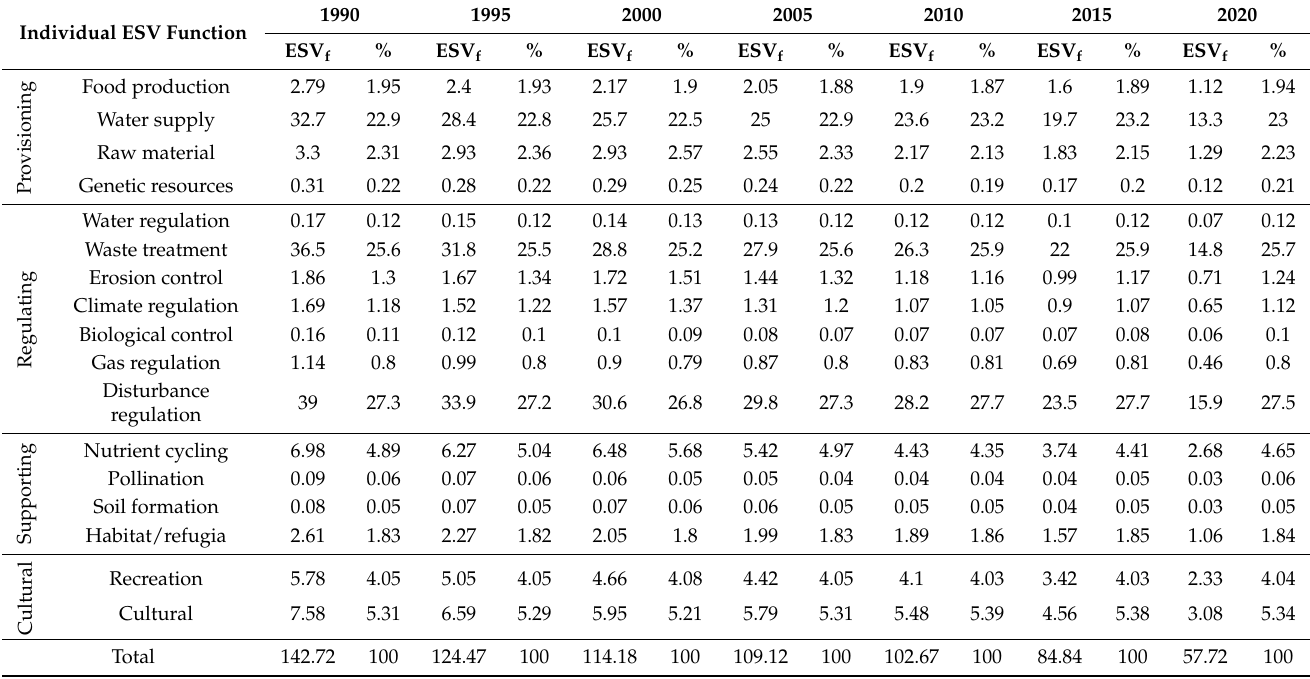
Table 9. Estimated individual ecosystem service function during the period 1990 to